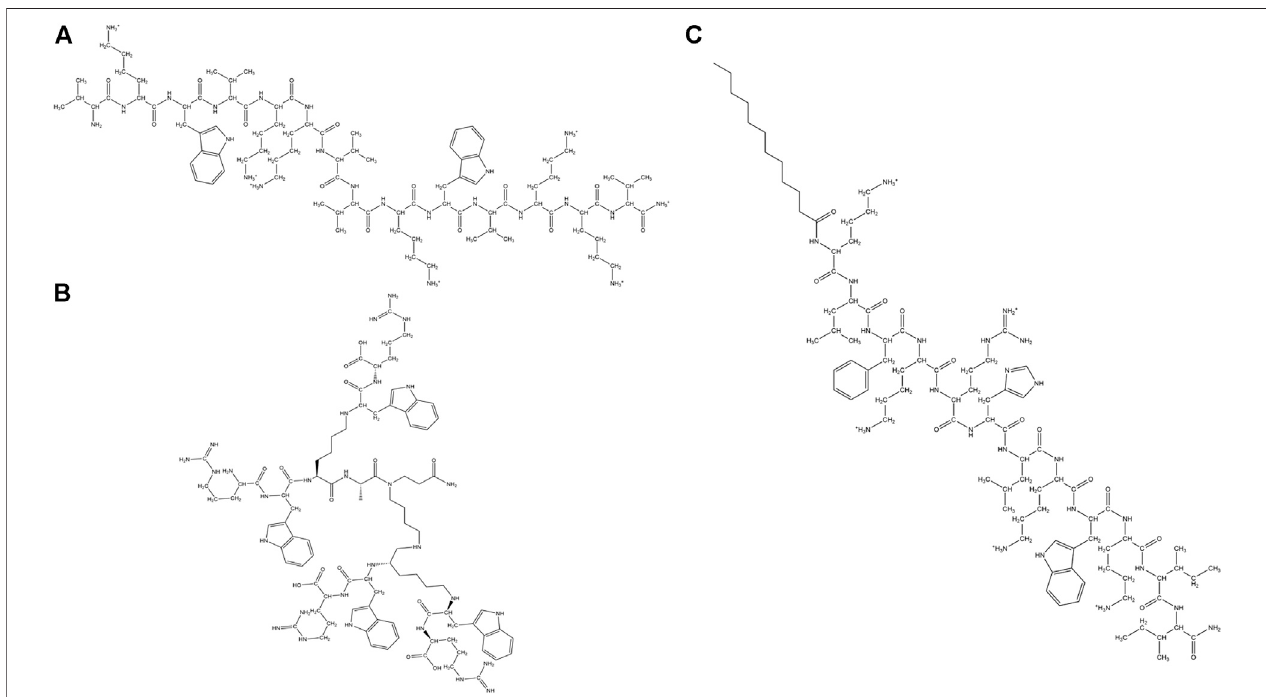
FIGURE6| ExamplesofsyntheticcationicAMPs. (A) VV-14(Panditetal.,2020). (B) Dendrimericpeptide:(RW) 4D (Houetal.,2009). (C) C 12 -SC4(Chu-Kungetal., 2004).